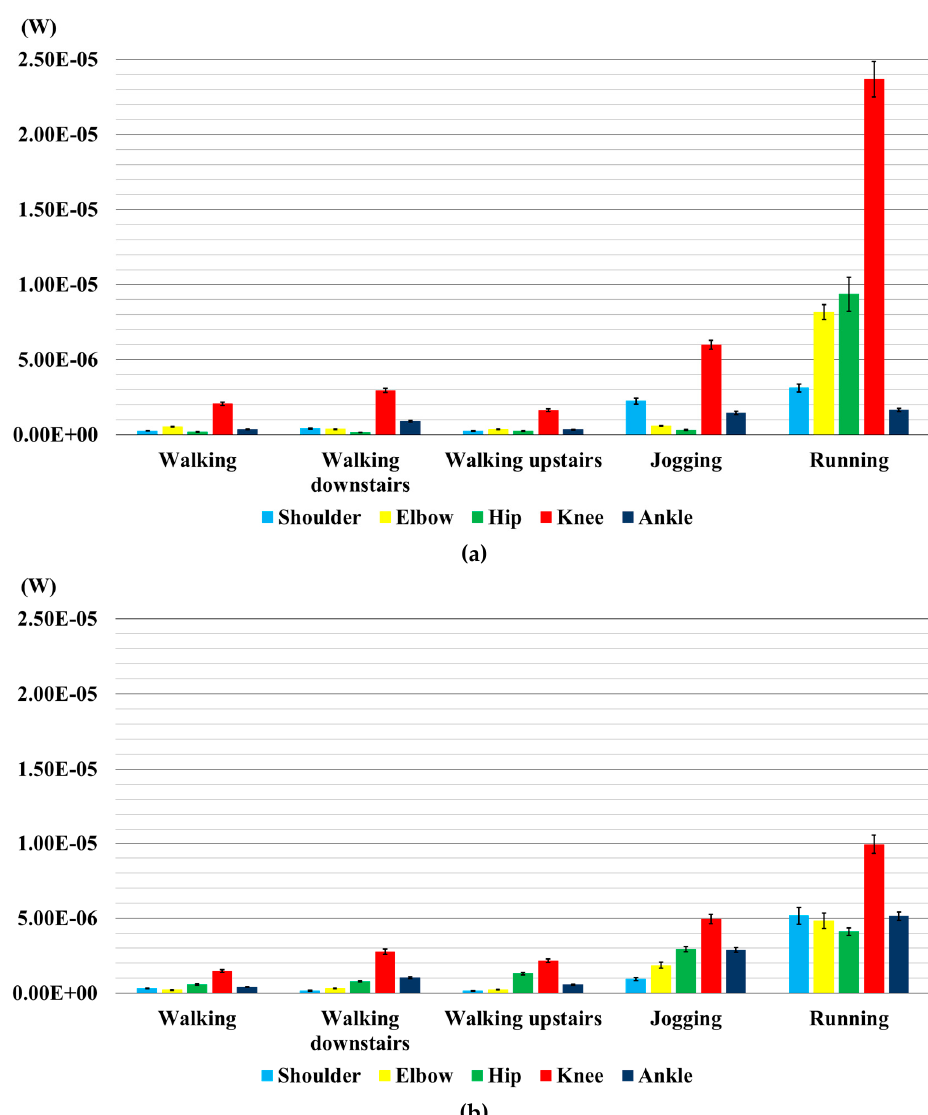
Figure 6. Comparison of the calculated grand mean values of power output on each joint for each activity. Error bars represent standard deviations. ( a ) P-876.A12; ( b ) LDT4-028k. Table 7. Comparison between the two transducers based on the five locomotion activities: lead